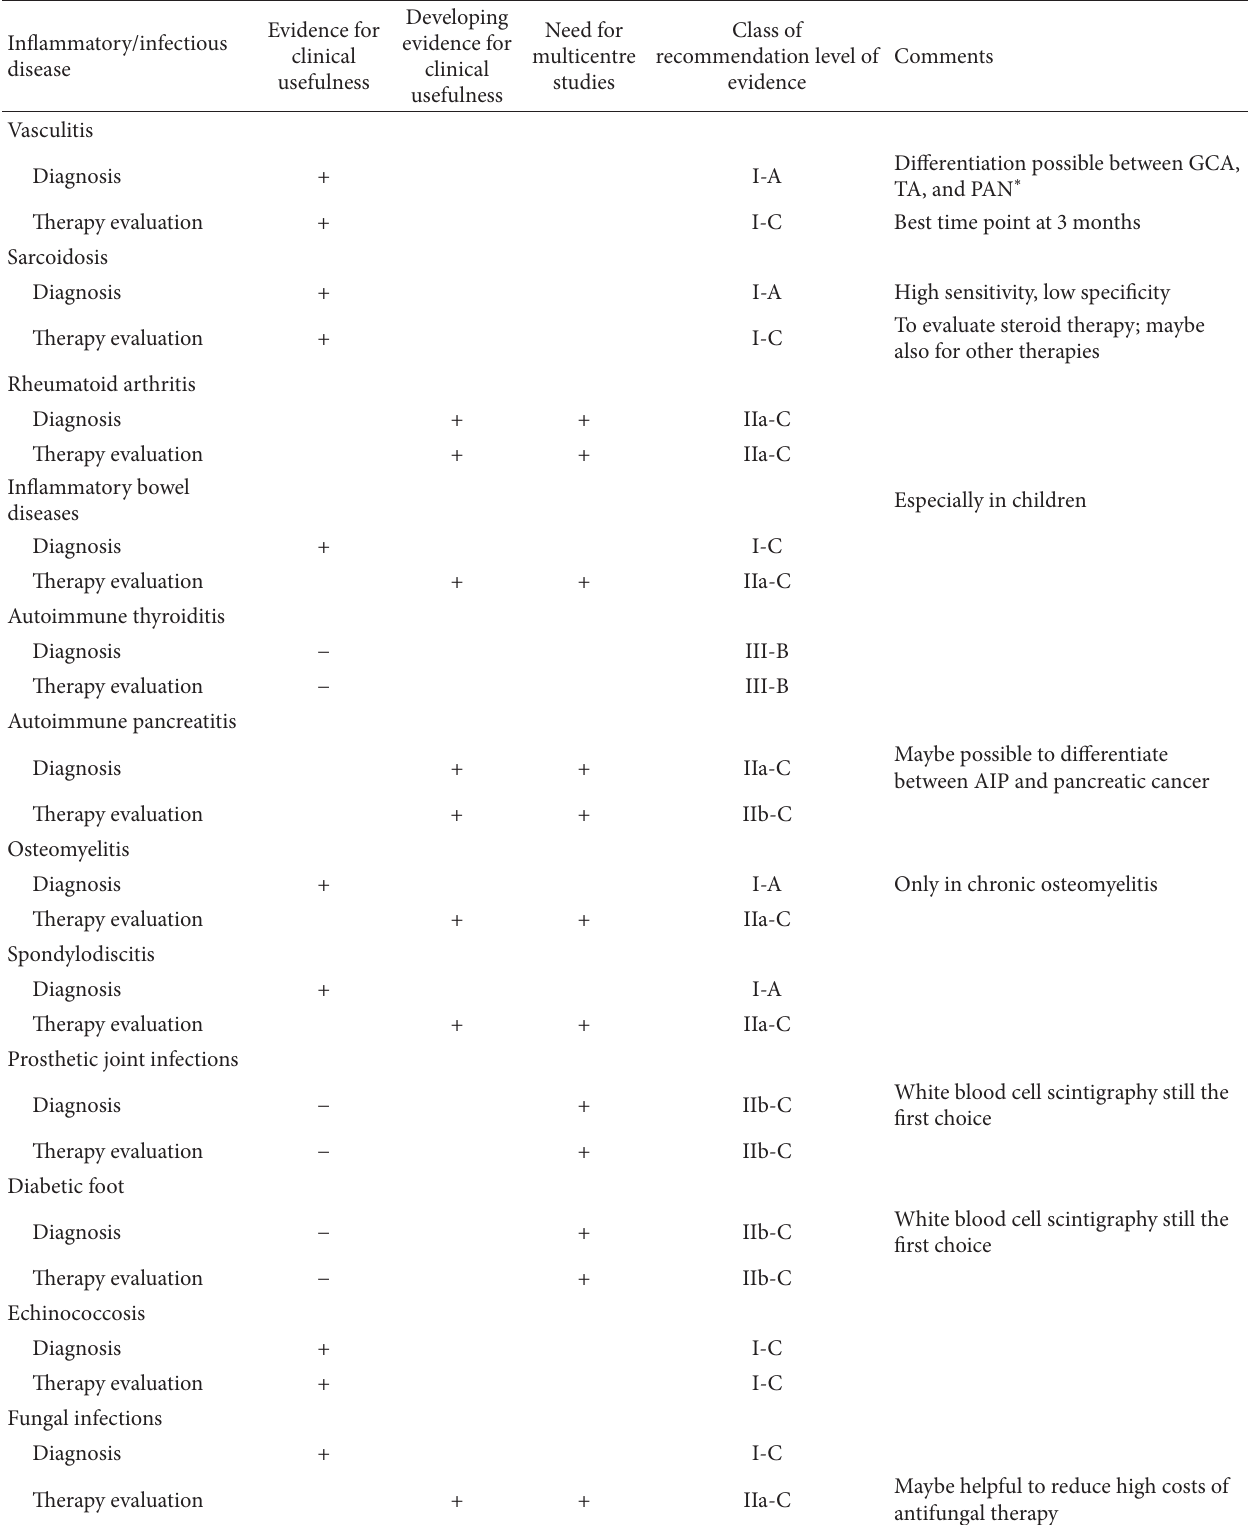
Table 1: Applications of FDG-PET for diagnosis and therapy evaluation in various inflammatory and infectious diseases. Evidence Inflammatory/infectious disease